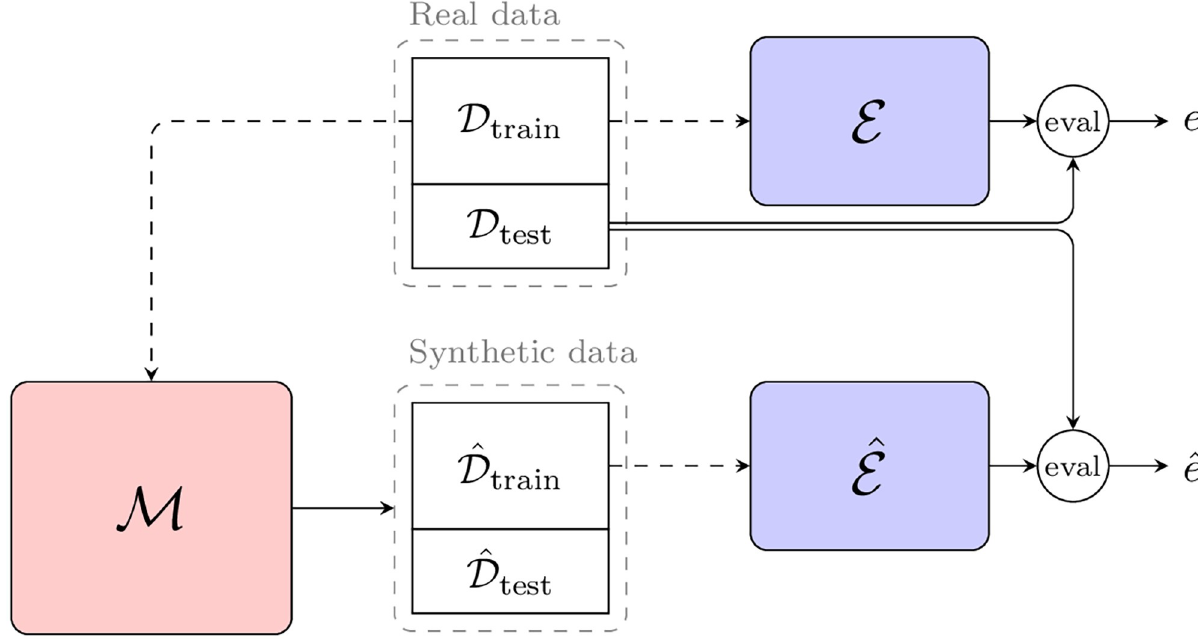
Fig 7. Conceptual overview of the experimental pipeline. The generative model M is trained with the real training data, allowing it to generate a synthetic data set. Two identical evaluation models E and ^ E are then trained with the real or synthetic data, respectively. Finally, these evaluation models are tested on the real data, yielding the metric e , derived from the real training set and that derived from the synthetic training data, ^ e .